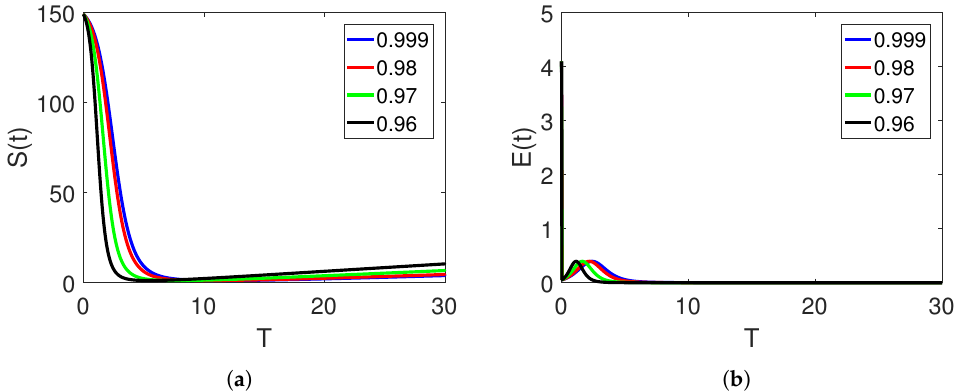
Figure 1. Dynamics of the susceptible class ( a ) and exposed class ( b ) on different arbitrary fractional order ς on sub interval [ 0, t 1 ] and [ t 1 , T ] of [ 0, T ]